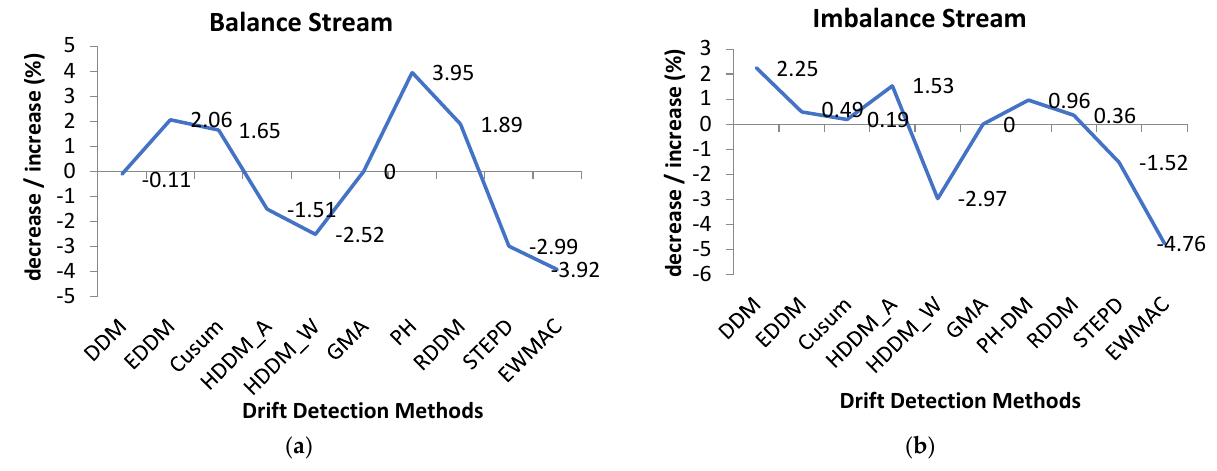
Figure 10. Effect of drift detection methods on base classifier’s performance in case of incremental drift: ( a ) incremental drift without class imbalance; ( b ) incremental Drift with class imbalance.